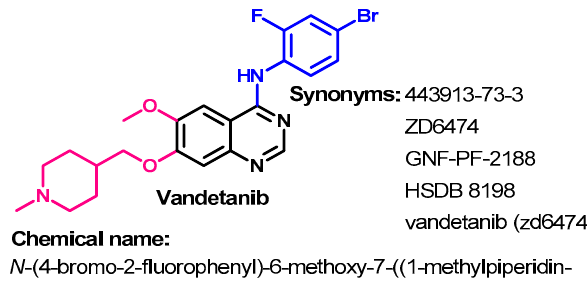
Figure 62. Chemical structure/name/synonyms of vandetanib.